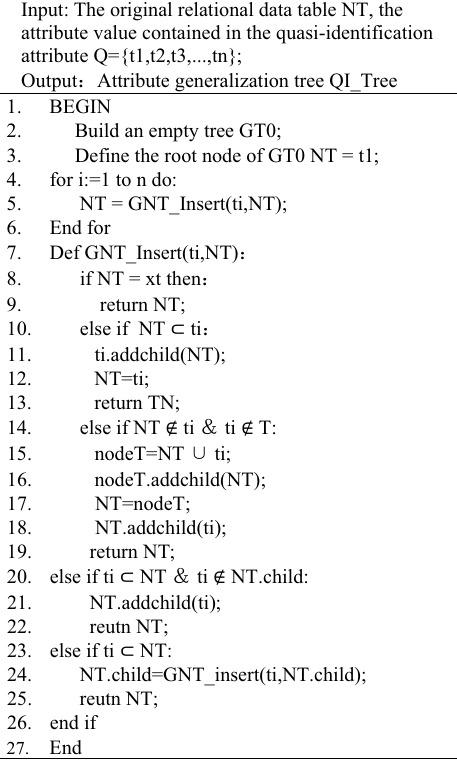
Algorithm 1: Building an attribute generalization tree Input: The original relational data table NT, the attribute value contained in the quasi-identification attribute